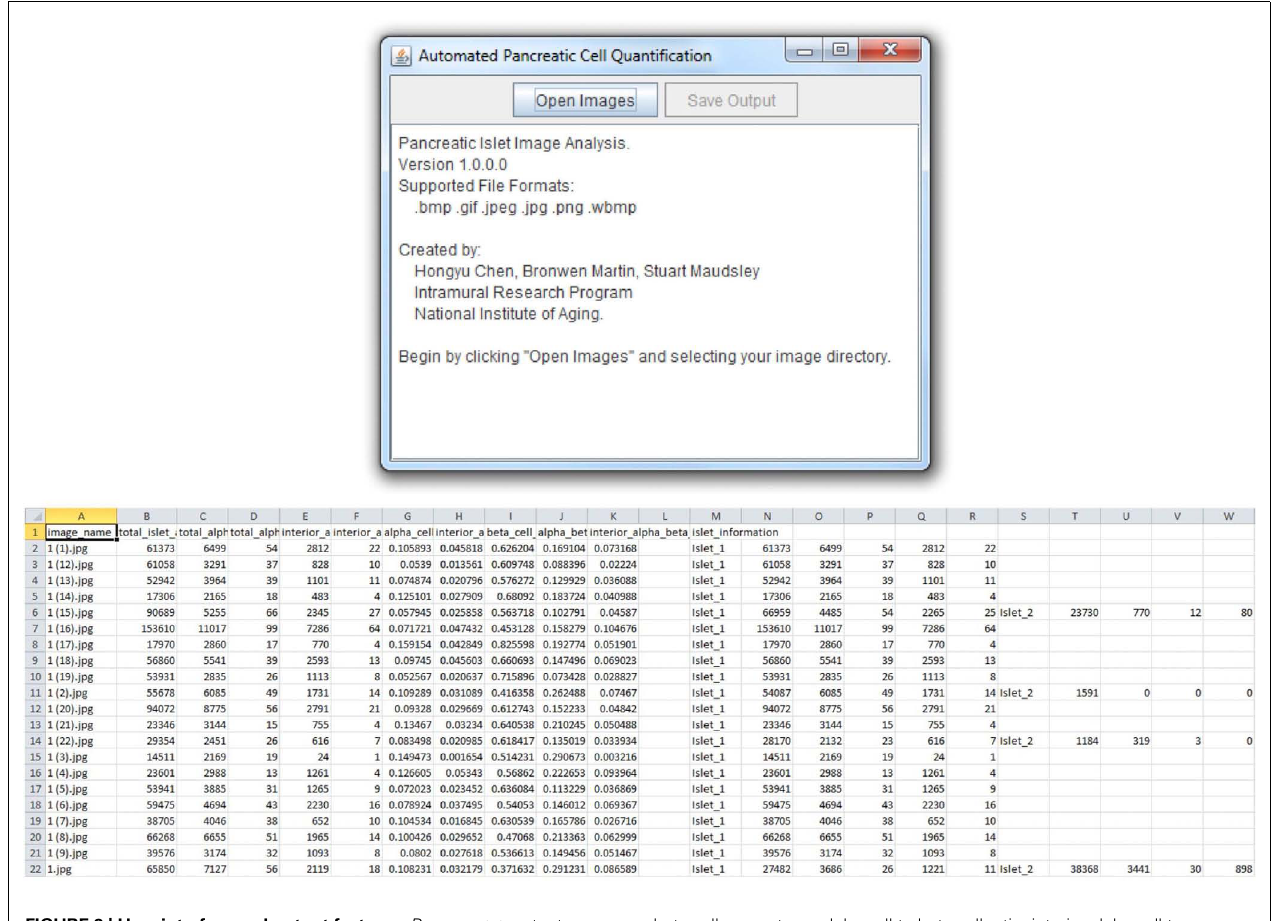
FIGURE 2 | User interface and output features. Pancreas ++ output features include (left to right): image name, total islet area, total alpha-cell area, total alpha-cell count, interior alpha-cell count, interior alpha-cell area, alpha-cell percentage, interior alpha-cell percentage,